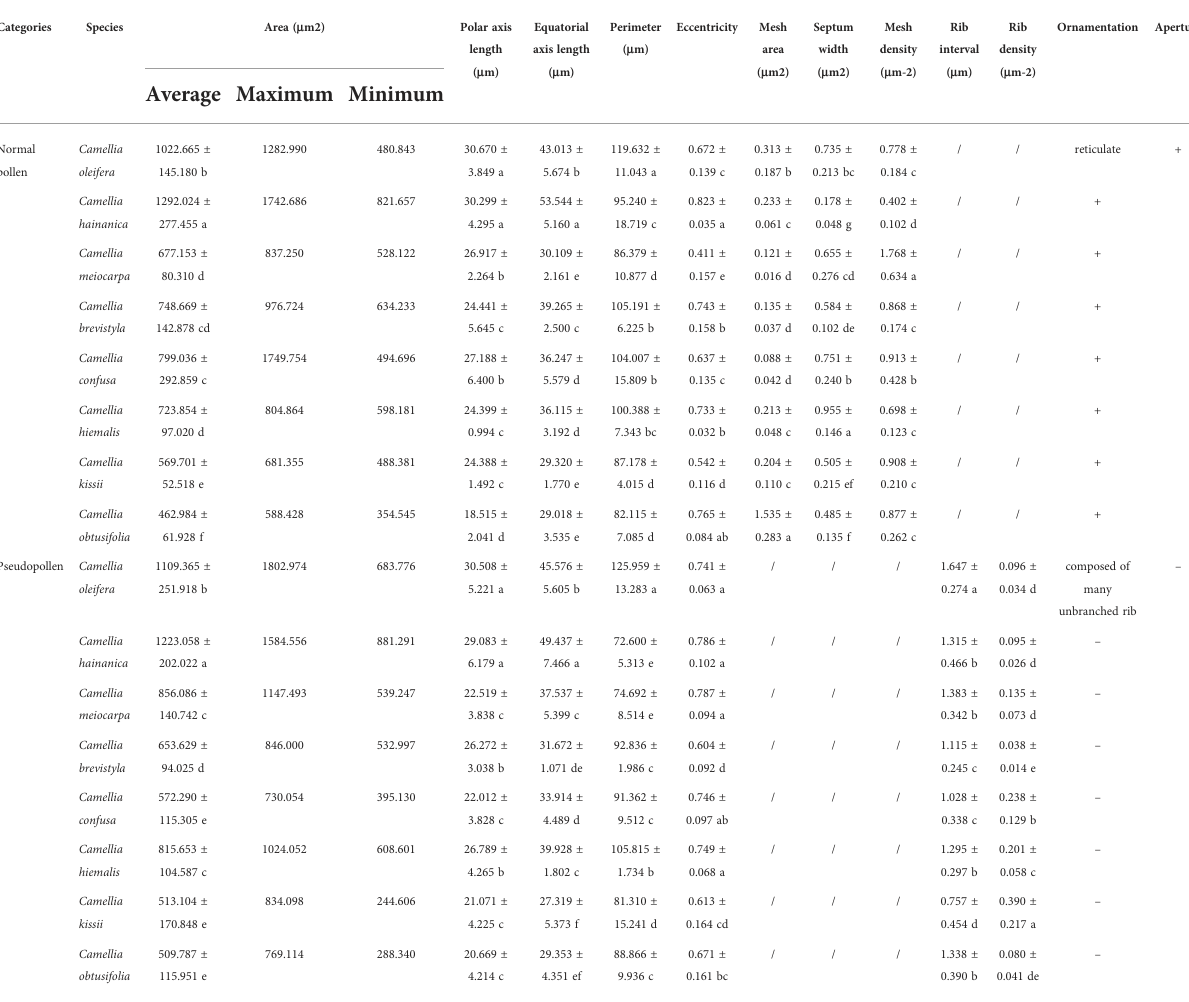
Within columns, different letters indicate signi fi cant differences at P <0.05. “ + ” , aperture presence; “ - ” , aperture